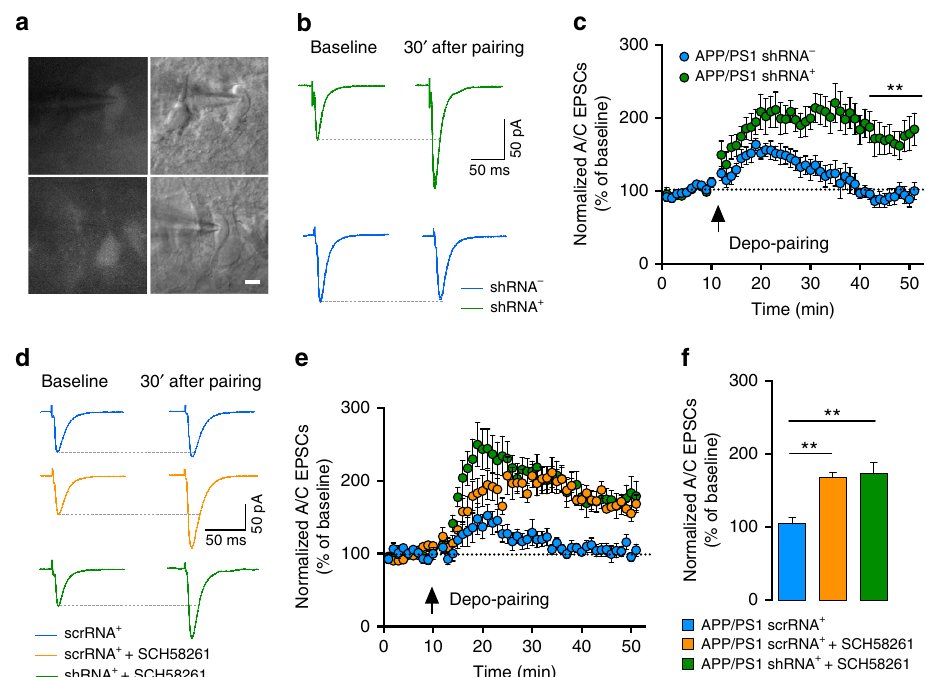
Figure 7 | Genetic silencing of neuronal A 2A R restores A/C LTP. ( a ) Example pictures of CA3 PCs infected with shRNA lentivirus. Infected cells (shRNA þ ) and non-infected cells (shRNA (cid:2) ) in the proximity of infected cells were patched for the experiments in b . Scale bar represents 10 m m. ( b ) Example traces representing average A/C-EPSCs 10min before and 30min after LTP protocol in infected and non-infected cells. ( c ) Summary time course of normalized A/C-EPSCs during depo-pairing LTP protocol, recorded from APP/PS1 mice injected with A 2A R shRNA; in shRNA þ cells there was a rescue of the A/C LTP ( n ¼ 7) that was absent in shRNA (cid:2) cells ( n ¼ 7, ** P ¼ 0.001, Mann–Whitney test, Supplementary Table 1). ( d ) Example traces representing the average of A/C-EPSCs 10min before and 30min after depo-pairing LTP protocol in infected cells with A 2A R shRNA or srcRNA lentivirus. ( e ) Summary time course of normalized A/C-EPSCs recorded from APP/PS1 mice during LTP protocol performed in scrRNA þ cells ( n ¼ 9) in the absence and scrRNA þ ( n ¼ 7) or shRNA þ cells ( n ¼ 9) in the presence of SCH58261 (50nM). ( f ) Bar graph representing mean LTP amplitude recorded at 30–40min after depo- pairing protocol represented in e . APP/PS1 cells infected with scrRNA virus (scrRNA þ ) do not sustain LTP (Supplementary Table 1). A 10-min incubation period with SCH58261 increased LTP amplitude of scrRNA þ cells to levels similar to the genetic silencing of A 2A R (Supplementary Table 1). In shRNA þ cells, SCH58261 did not further increase the LTP levels (** P ¼ 0.0014, Kruskal–Wallis test with Dunn’s multiple comparison test between groups). All electrophysiology recordings were performed in the presence of 10 m M bicuculline and 3 m M